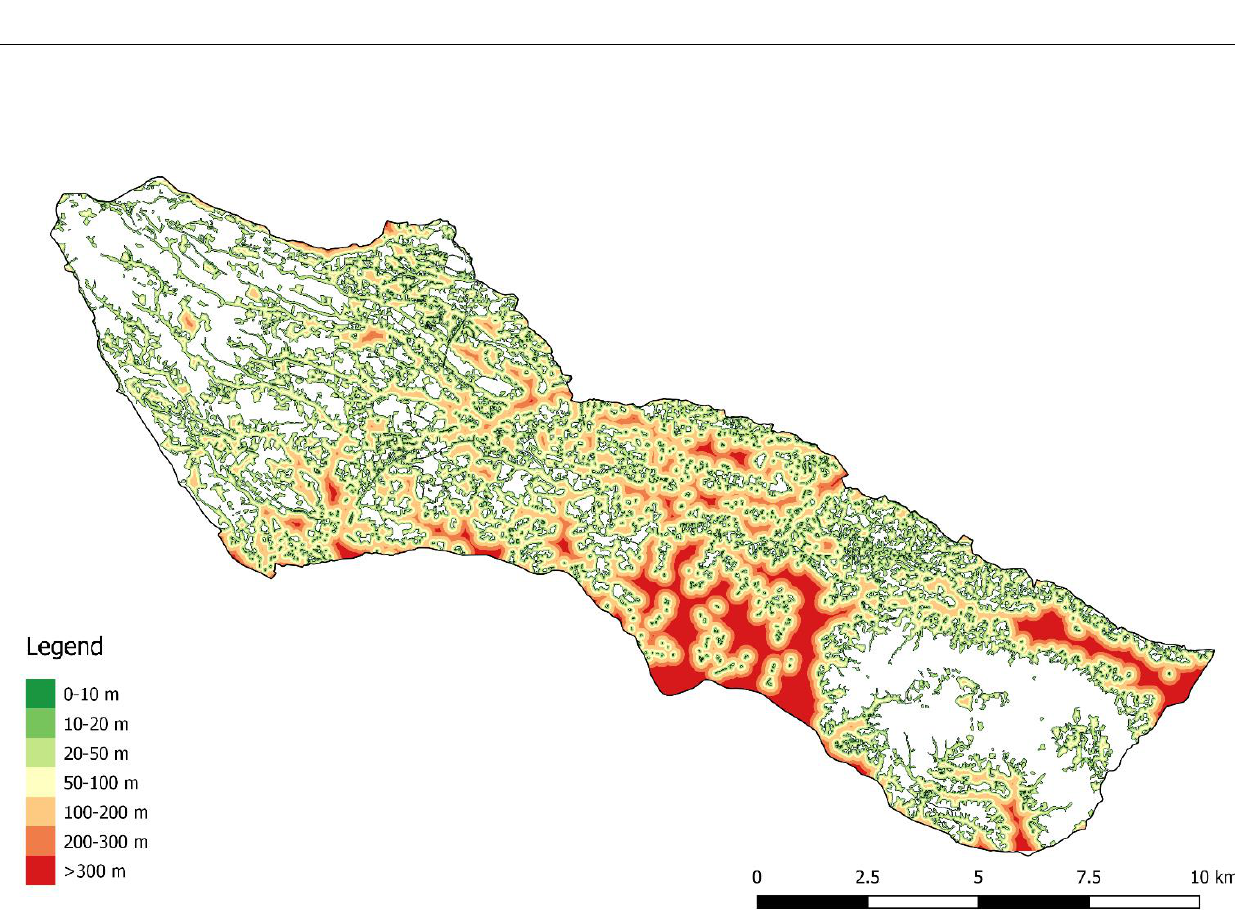
Figure 5. Map of the proximity of agricultural and urban areas from igune and other small woods for 2021. Results for 2002 are the same.